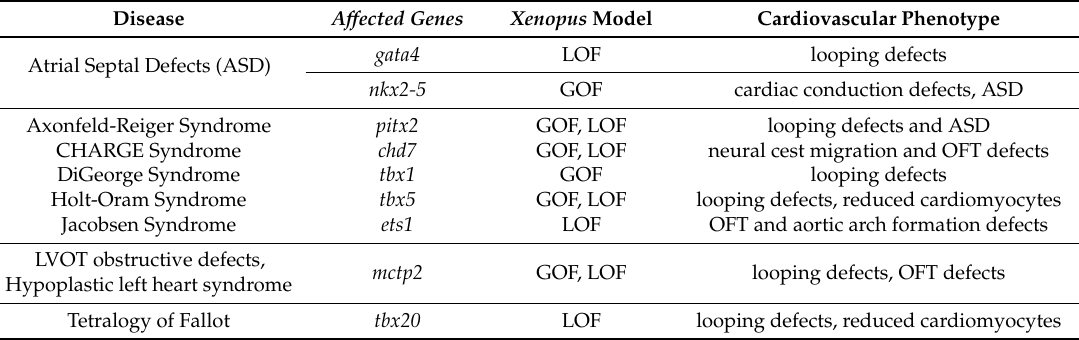
Table 2. Selected Xenopus models for human CHDs (see main text for